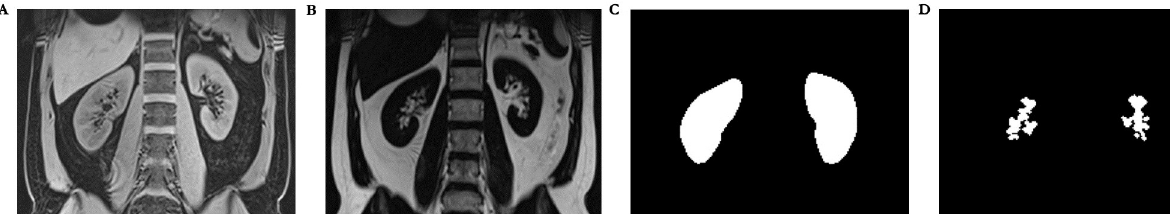
Fig 1. Exemplary segmentation of a coronal T1w Dixon-VIBE-dataset (A). Corresponding fat only images (B). A whole kidney mask is generated using thresholding and active contours (C). Next the renal sinus fat is segmented using thresholding of fat isointense voxels (D).